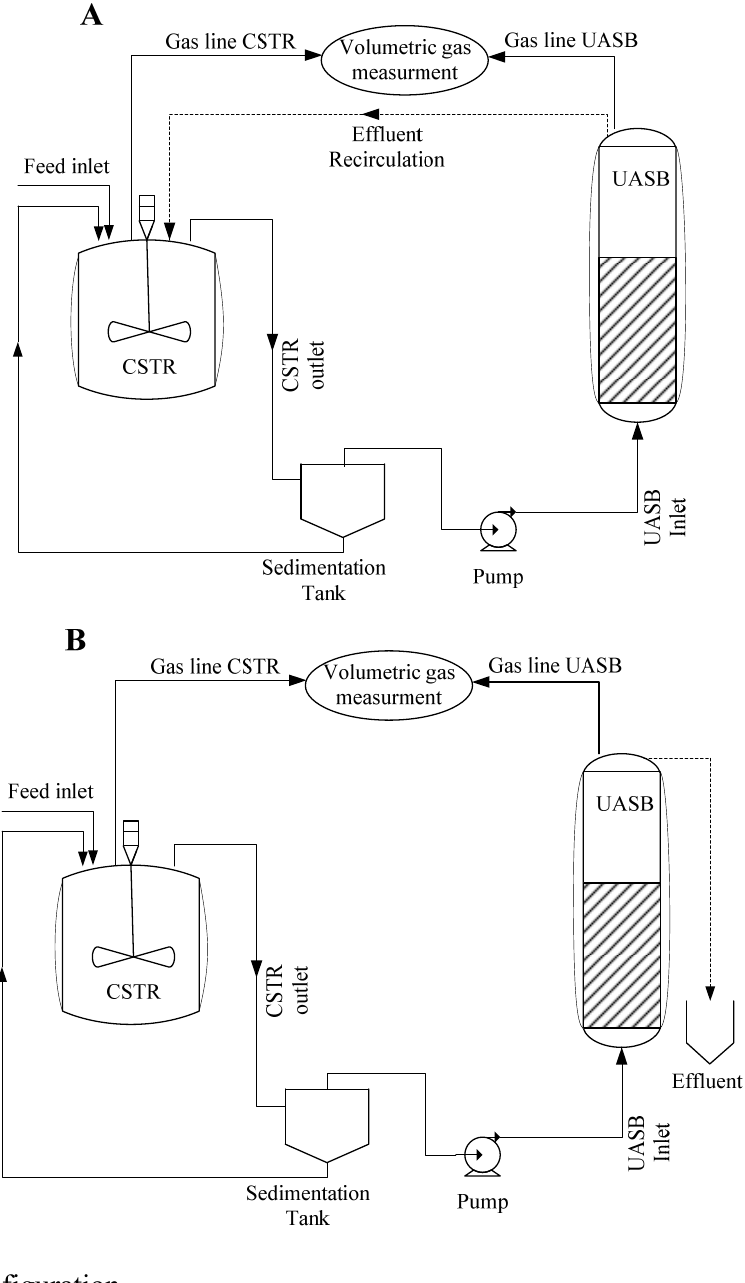
Figure 1. Schematic figure of the semi-continuous two-stage system. ( A ) with recirculation (Closed system), and ( B ) without recirculation (Open